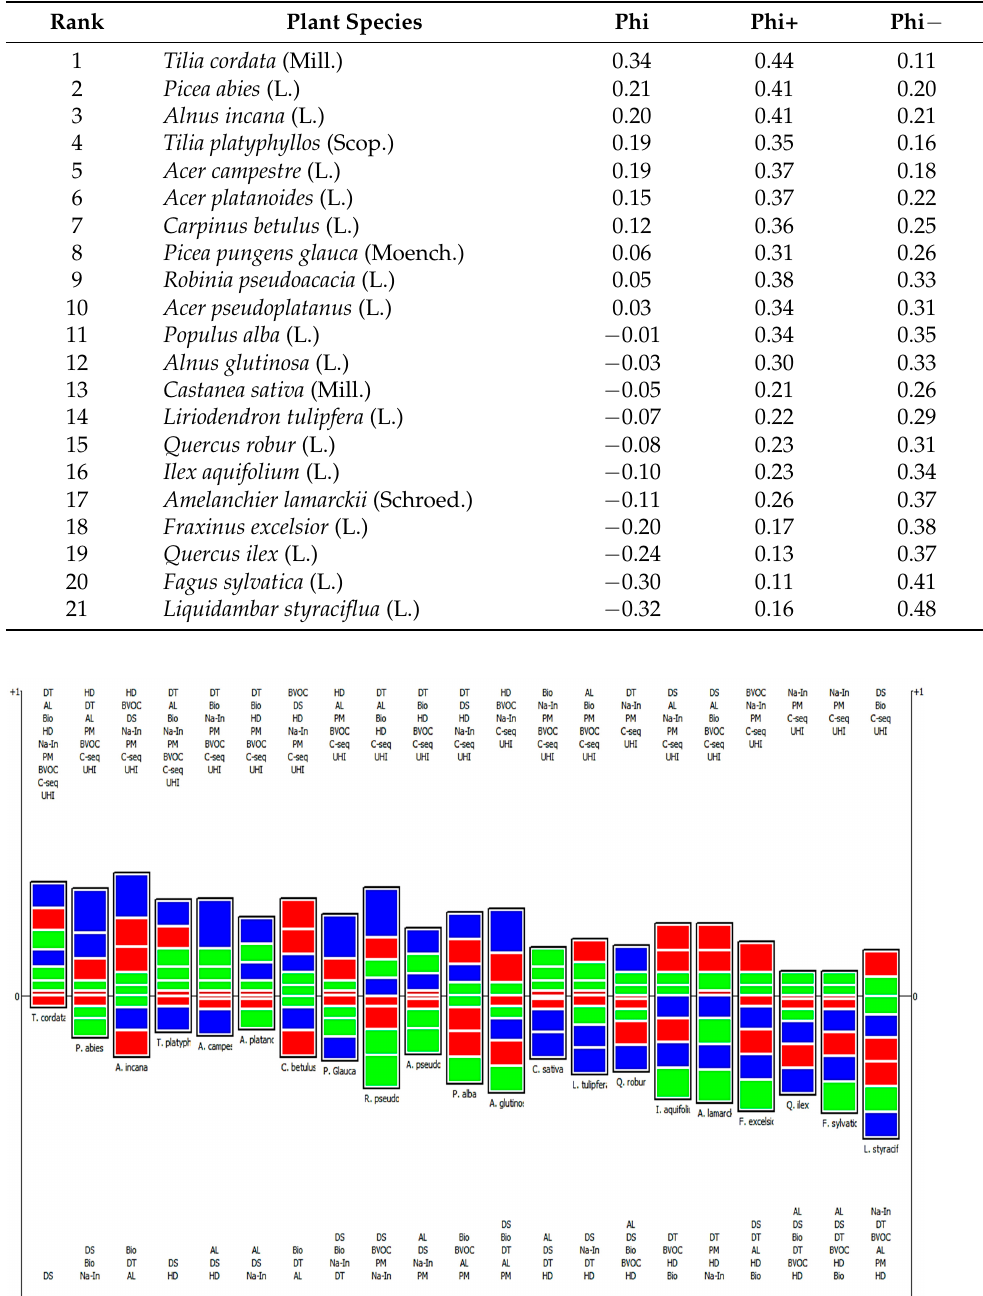
Table 6. The PROMETHEE table indicating the ranks of plant species based on the phi net flow score. Phi+ indicates the positive (strengths) and phi − indicates the negative (weakness) scores.